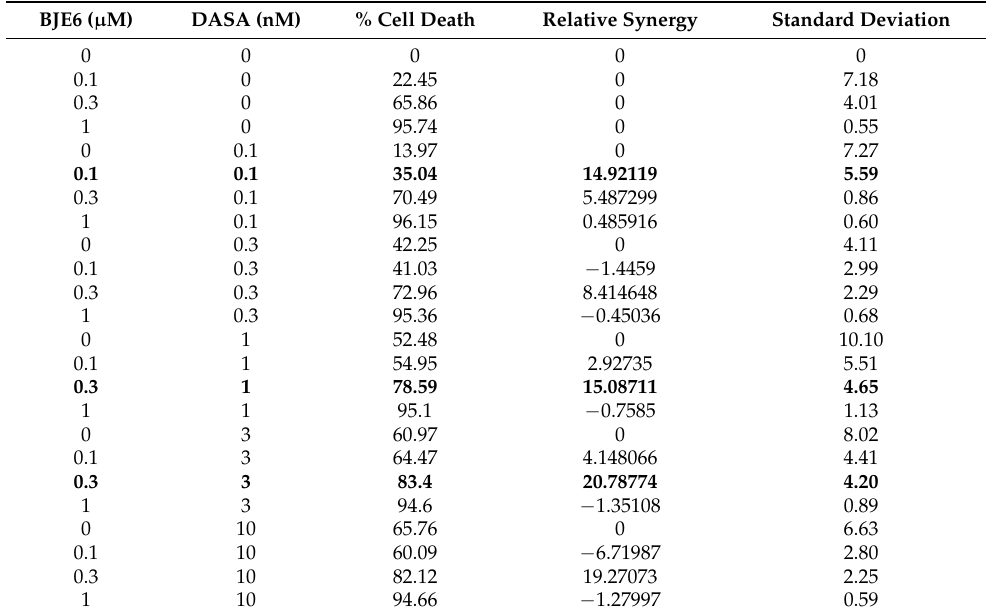
Table 2. Relative synergy of BJE6 and DASA for K562 cells calculated from data obtained in Figure 2E. Best relative synergy in